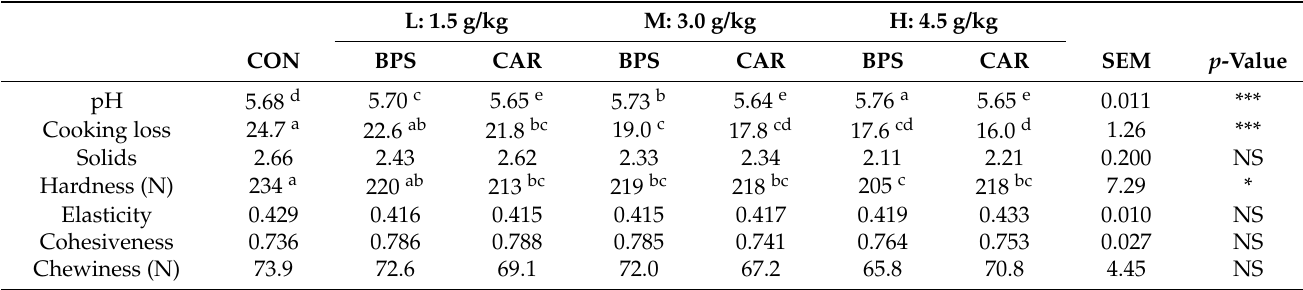
Table 2. Cooking loss and solids in the fluid lost, both expressed as percentages, and texture profile analysis results in minced lean-pork batter as a function of the amount and type of fibre-rich ingredient used ( n = 5). L: 1.5 g/kg M: 3.0